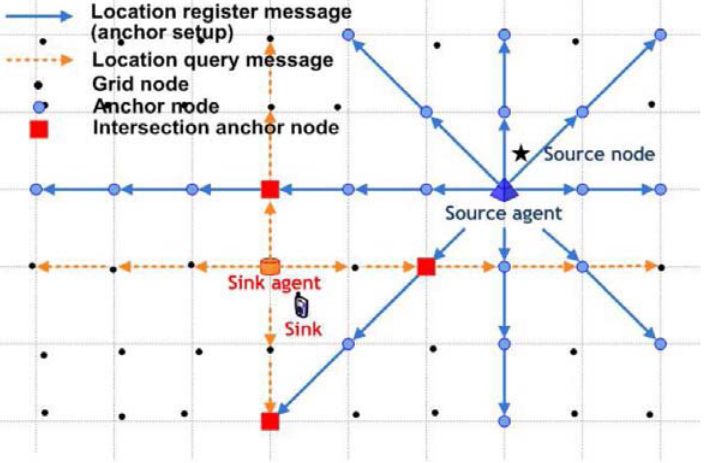
Figure 4. The anchor selection and the query and data dissemination processes.